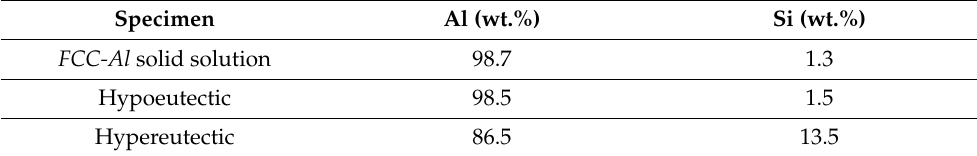
Table 1. Chemical compositions (wt.%) of the three tested specimens in this work.